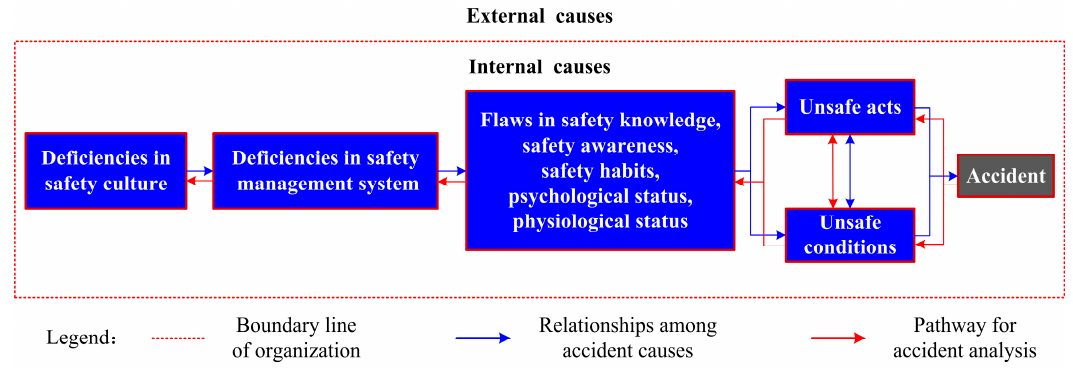
Figure 1. The improved accident causation model and the pathway for accident analysis [2,14,16,18,20].